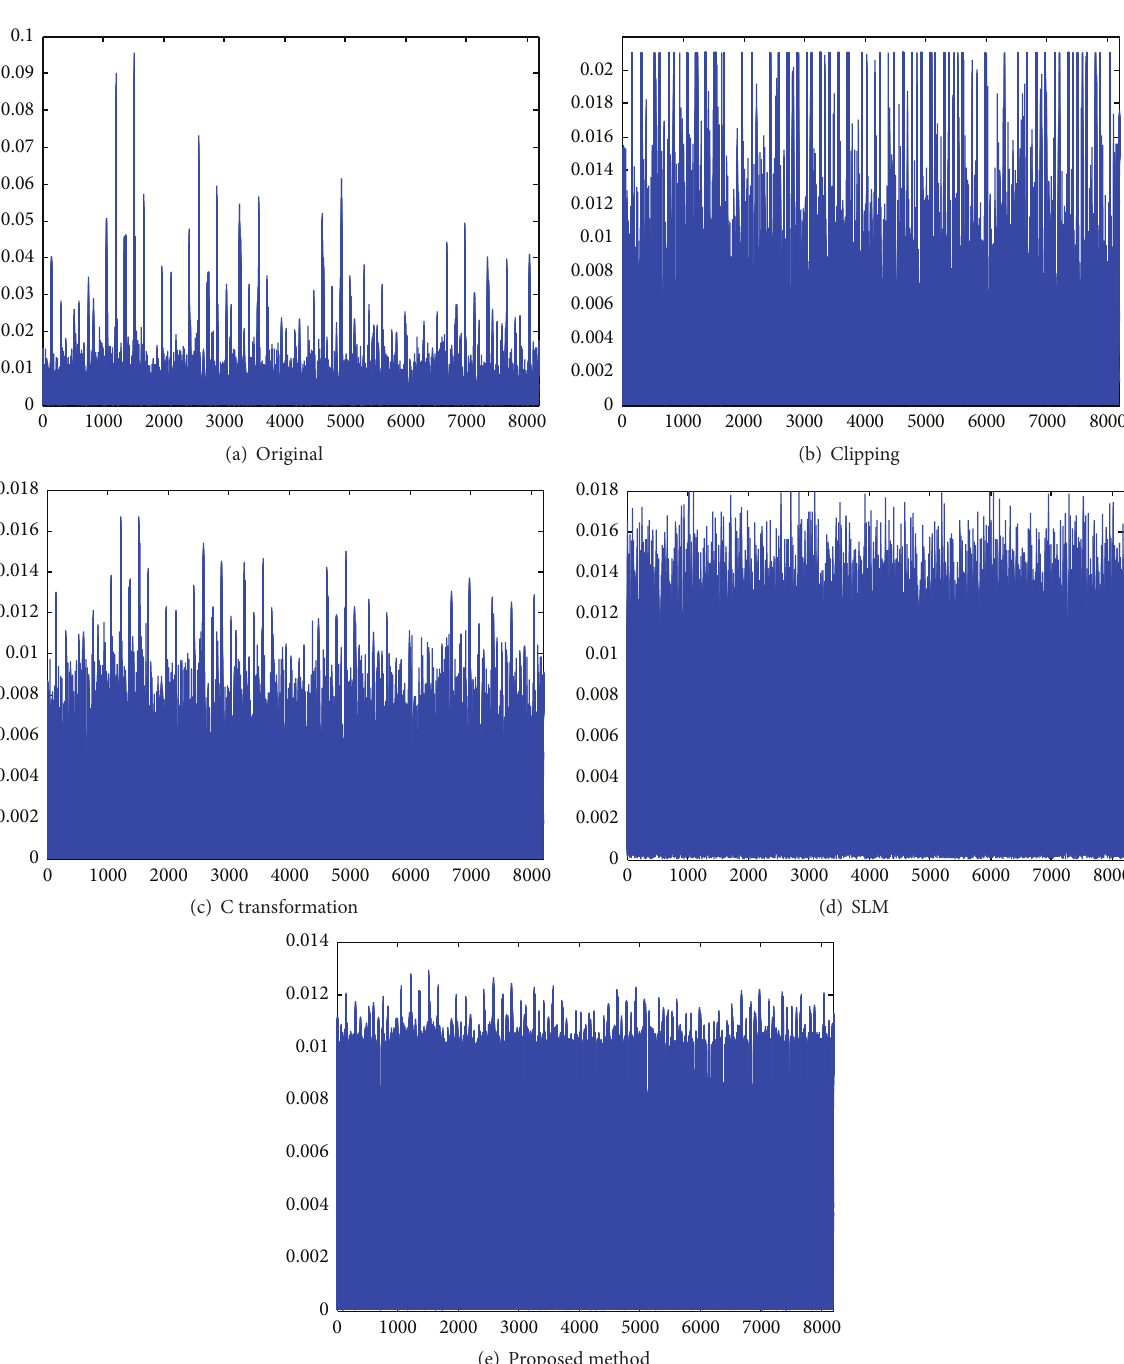
Figure 6: Amplitude of OFDM signals before and after